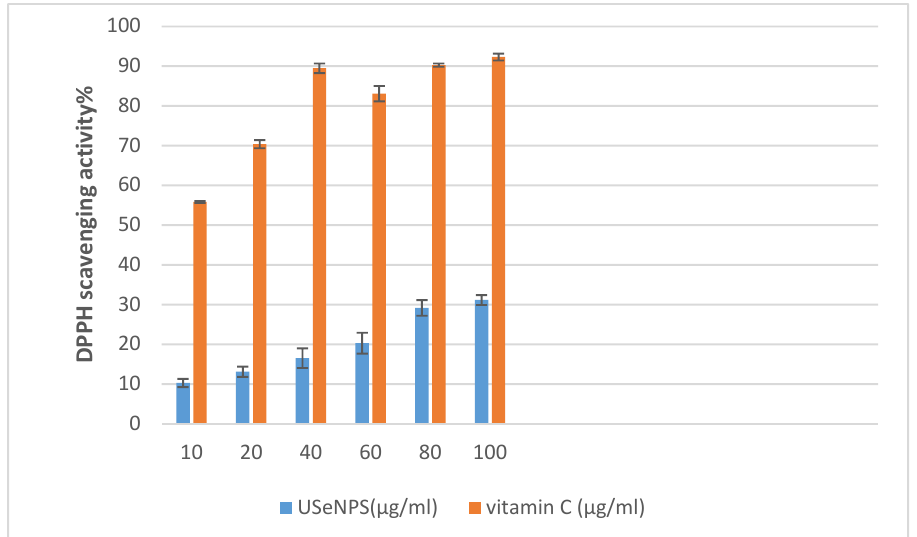
Figure 13. The effect of different concentrations of USeNPS on DPPH radical scavenging activity with (IC 50 ) 158.02 ± 0.07 and 4.48 ± 0.01 for USeNPS and vit. C (reference drug), respectively.